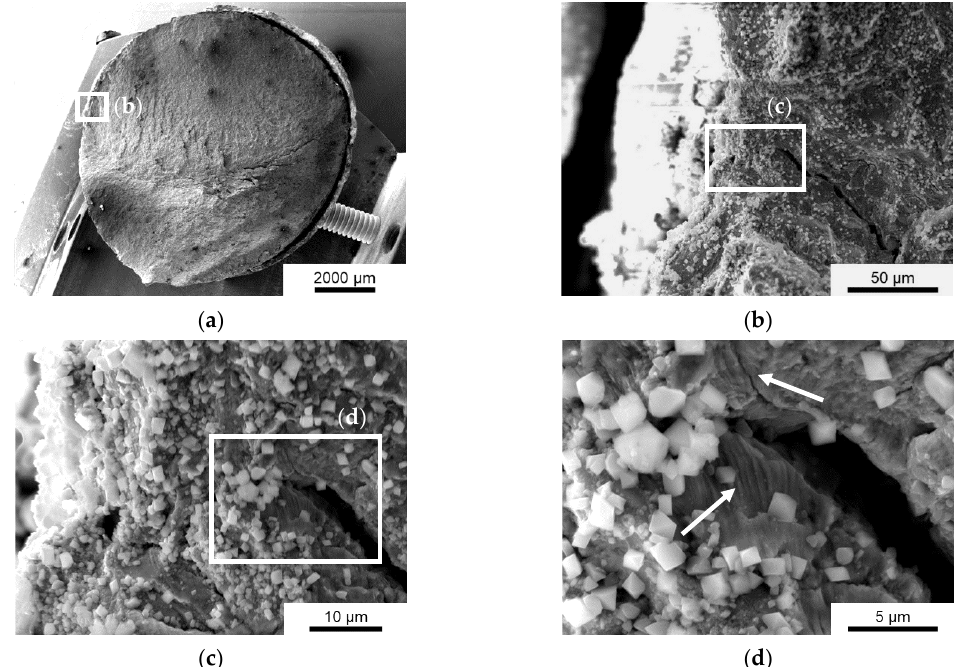
Figure 14. Fractography of machine hammer-peened (III) specimen loaded at 300 MPa and tested in 3.5% NaCl solution: ( a ) overview, ( b ) area of crack initiation with fatigue striations, ( c ) area of crack initiation with fatigue striations at higher magnification and ( d ) area of crack initiation with fatigue striations at higher magnification.